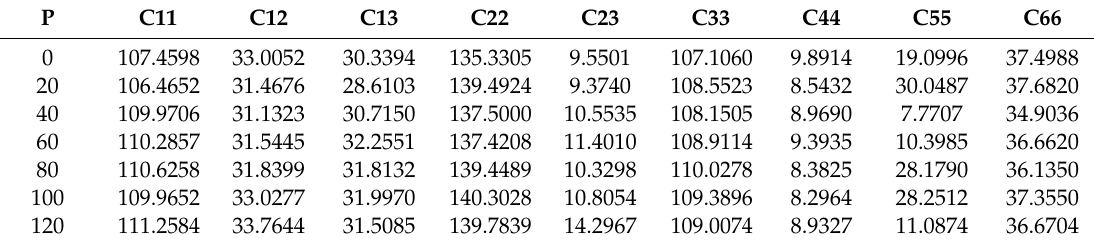
Table 5. Elastic constants of anhydrite crystals under di ff erent pressures